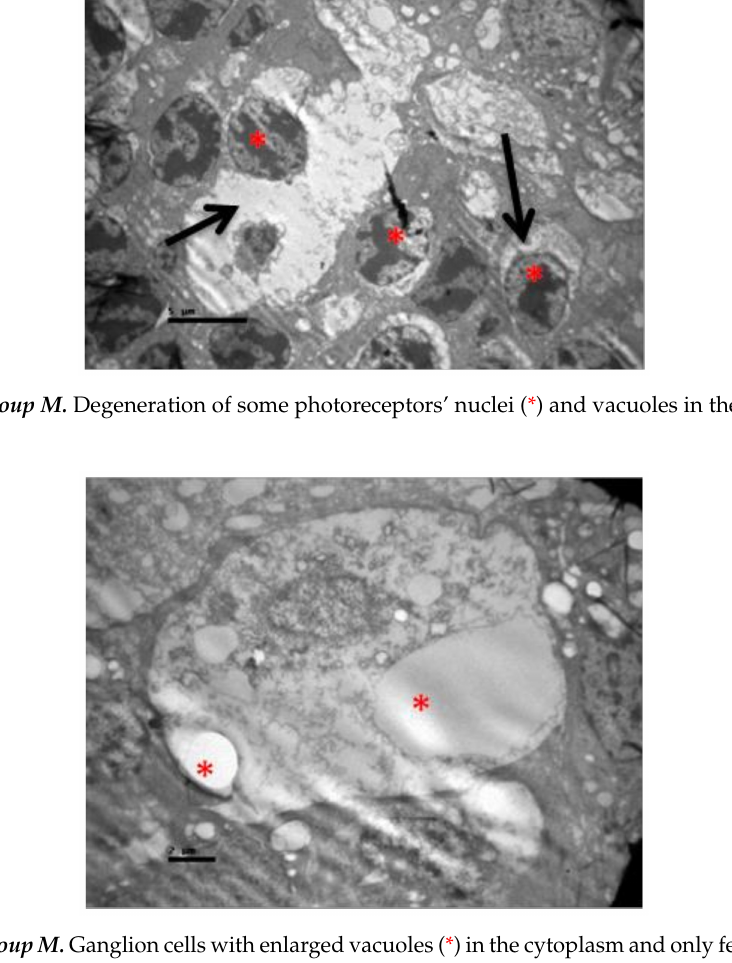
Figure 17. Group M. Ganglion cells with enlarged vacuoles (*) in the cytoplasm and only few